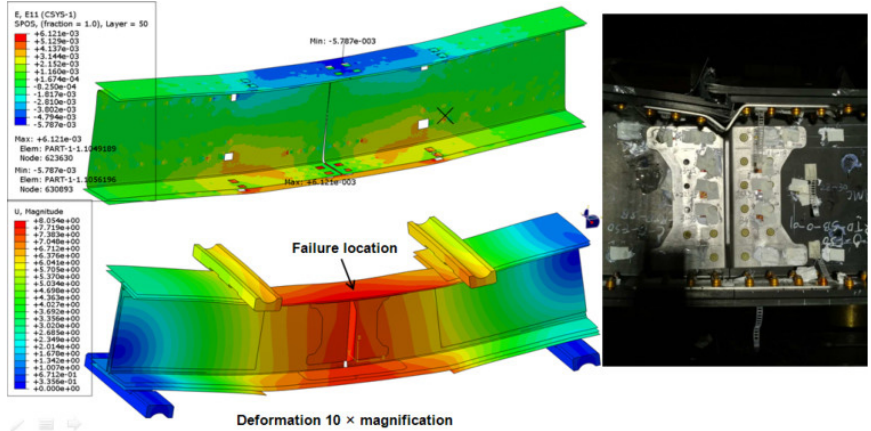
Figure 20. Morphologies of failure modes for composite C-beam fastened with multi-bolt joints. Reproduced with permission from [167], Elsevier, 2019.